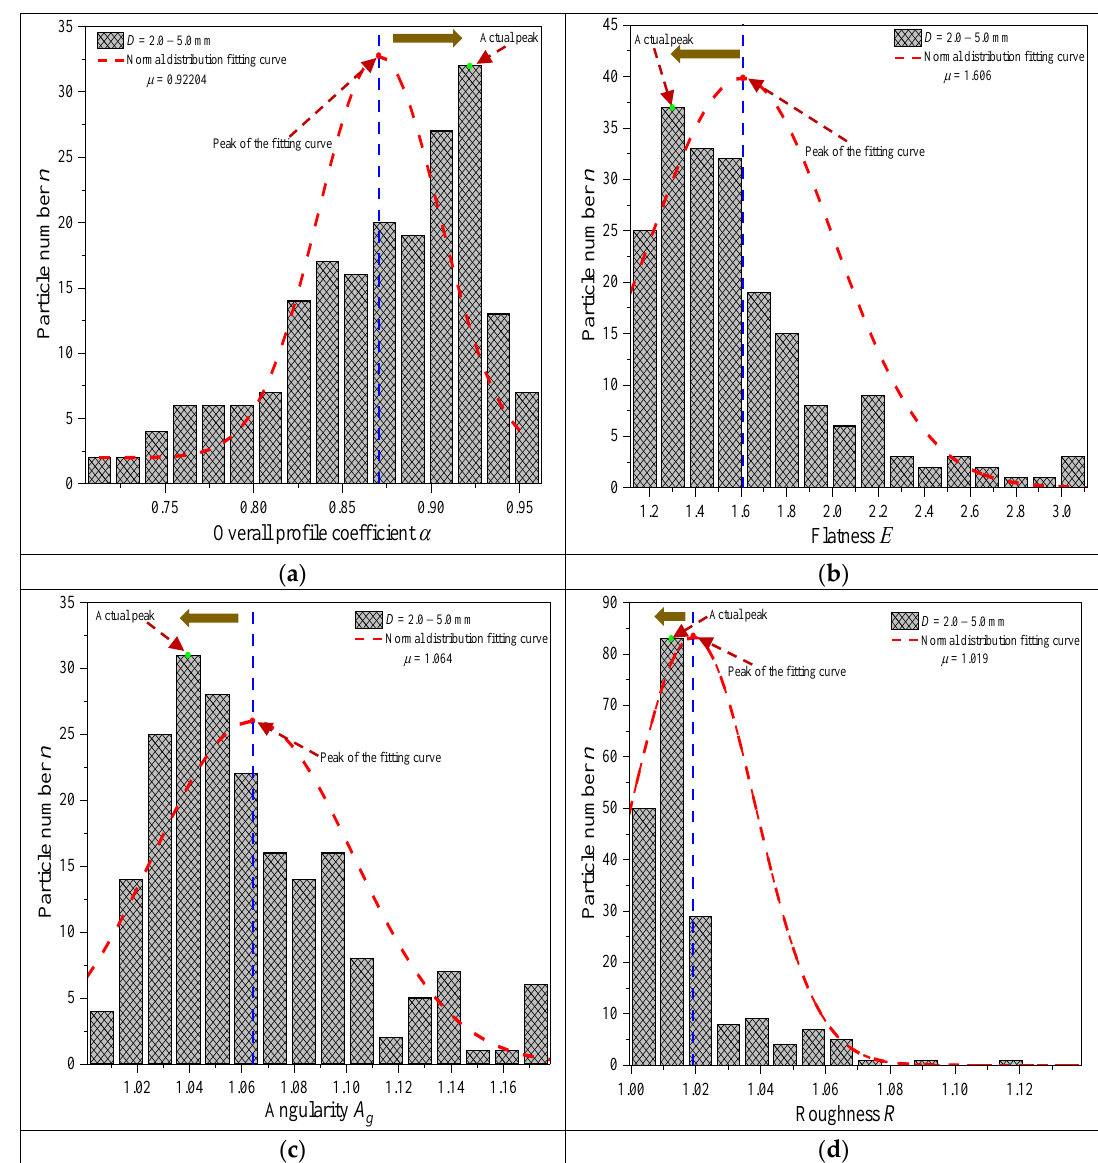
Figure 13. Distribution diagram of the shape parameters of coral sand with the particle size of 2.0–5.0 mm: ( a ) overall profile coefficient α , ( b ) flatness E , ( c ) angularity A g , and ( d ) roughness R .